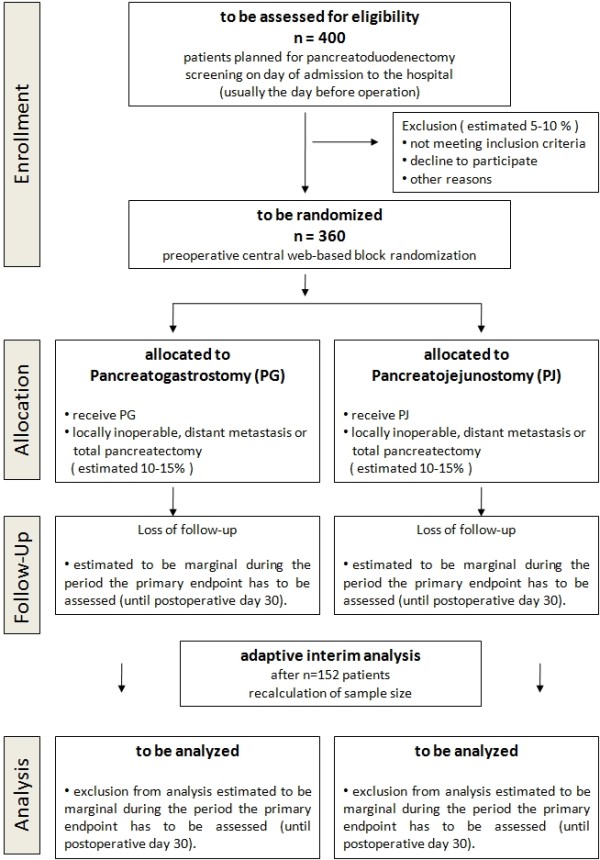
Trial flow chart.